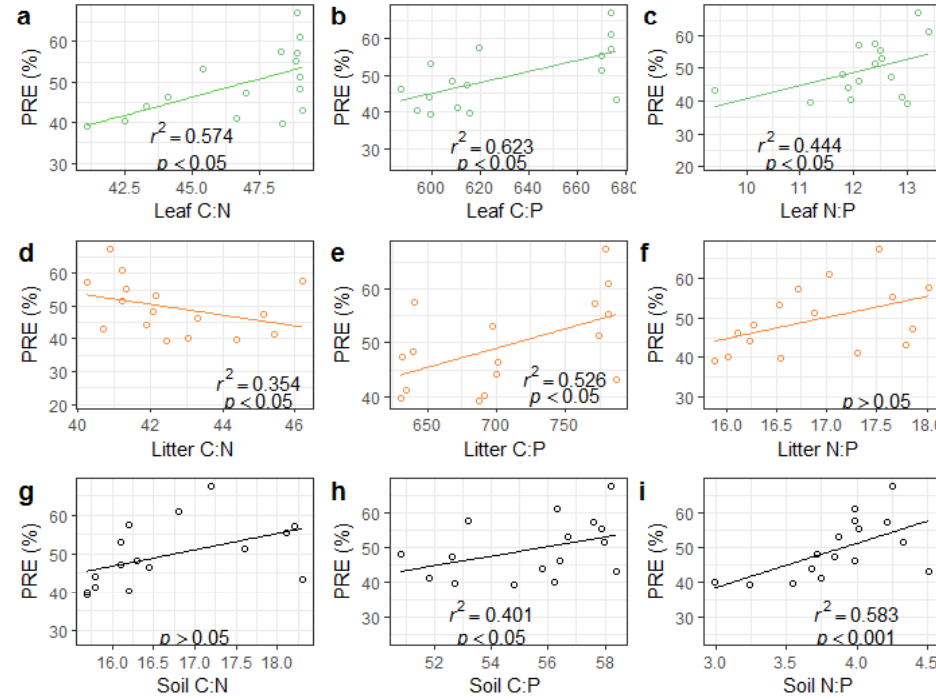
Figure A4. Relationships between PRE (P resorption efficiency) and leaf ( a – c ), litter ( d – f) , and soil ( g – i )